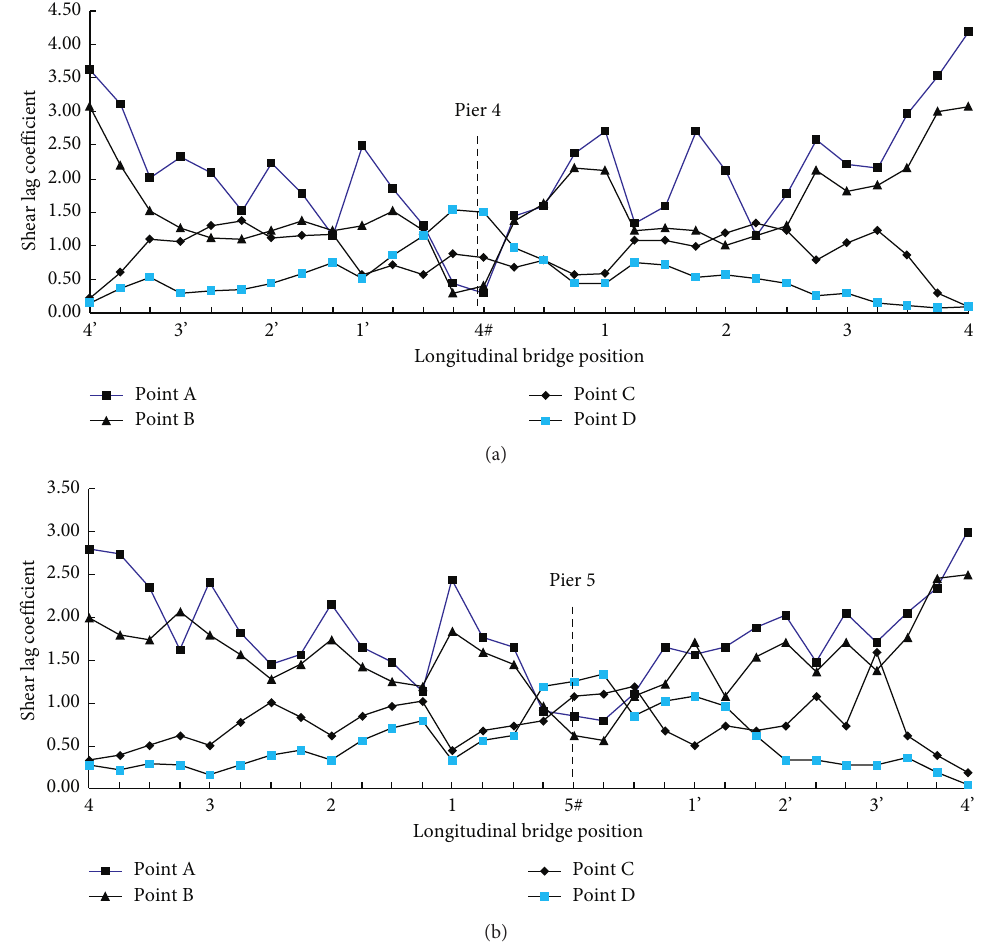
Figure 12: Distribution of shear lag coefficient along longitudinal direction (Condition 1): (a) Pier 4#; (b) Pier